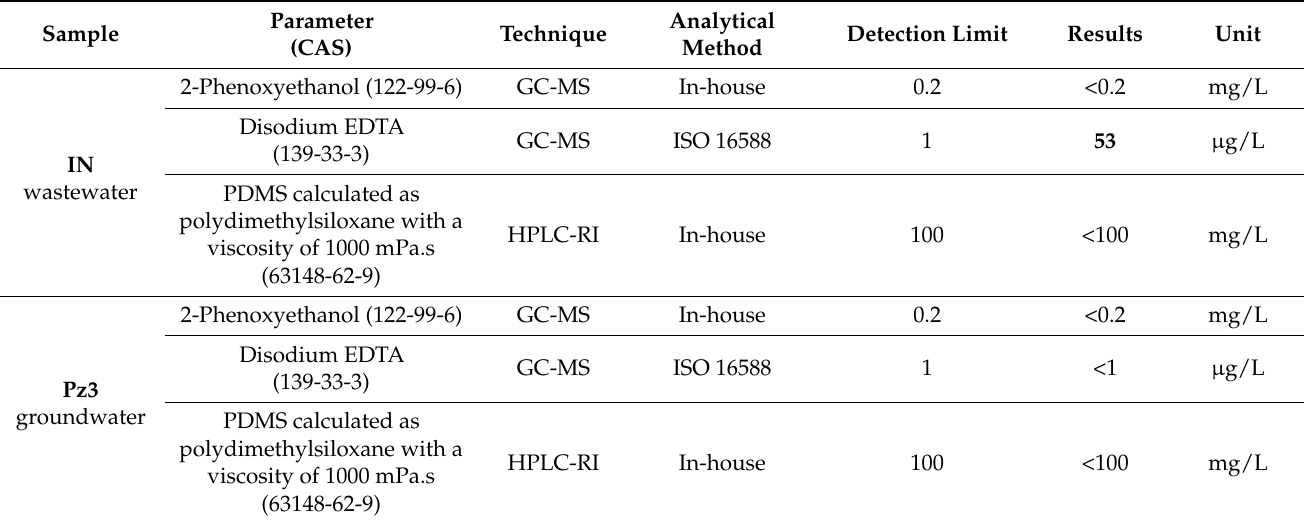
Table 2. Results of PCP analyses.